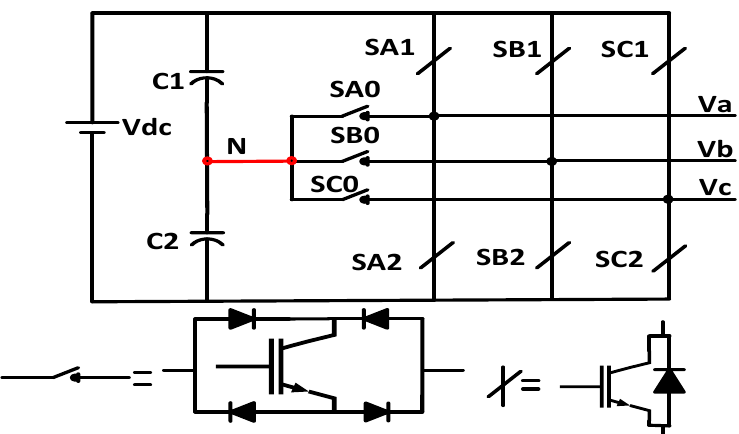
Figure 4. Topology of the transistor clamped three-level voltage source inverter.